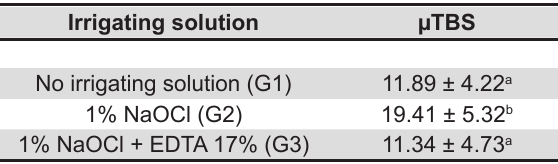
Table 1- Microtensile bond strength (µTBS) means ± standard deviations (MPa) of the self-etching adhesive system to coronal dentin after the different treatments